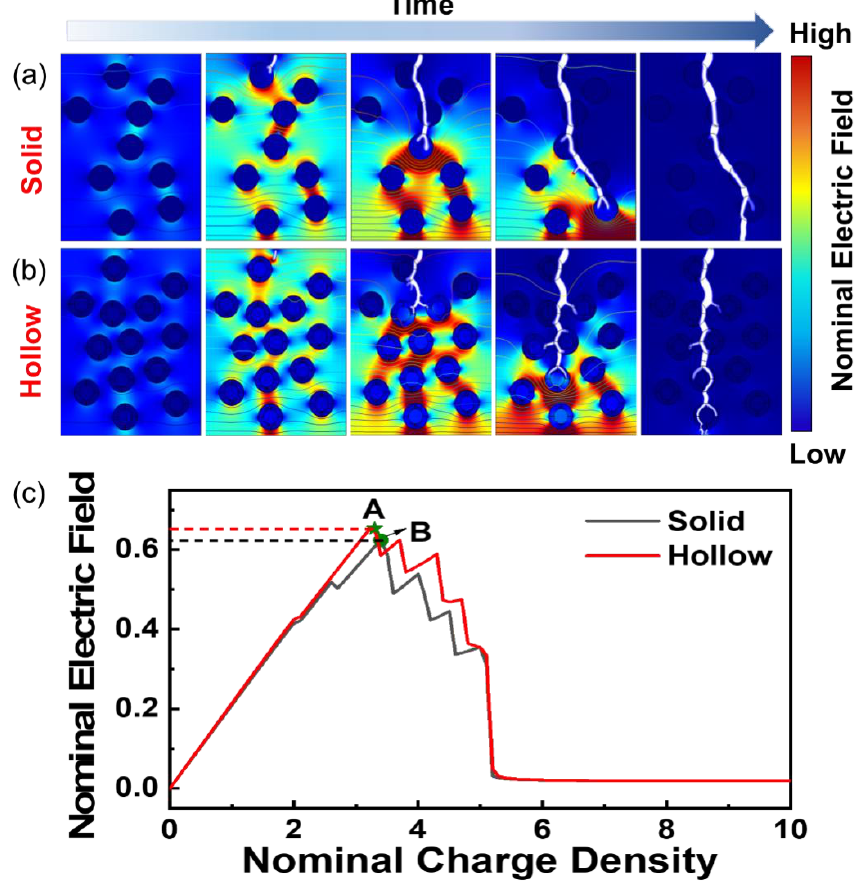
Figure 5. Finite element analysis of energy storage performance of TiO 2 /PI nanocomposites. Finite element simulation of breakdown evolution of TiO 2 /PI nanocomposites with ( a ) solid and ( b ) hollow nanoparticles. ( c ) Relationship between nominal electric field and charge density for PI-based nanocomposites with solid (grey curve) and hollow (red curve) nanoparticles.